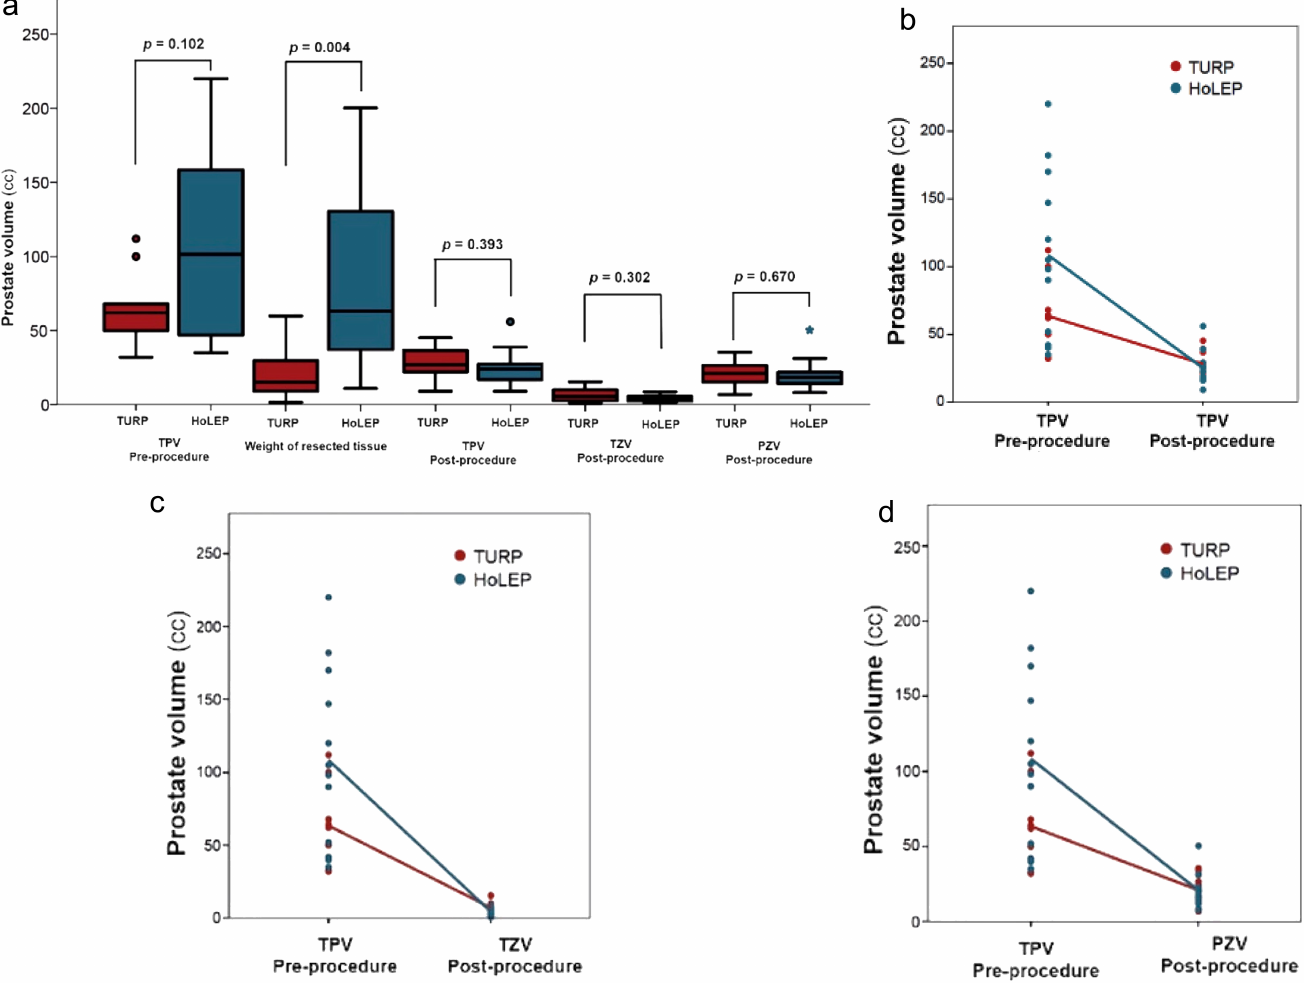
Figure 1. a-d. Comparison between zonal anatomy post-TURP and HoLEP. TURP, Transurethral resection of the prostate; HOLEP, Holmium laser enucleation of